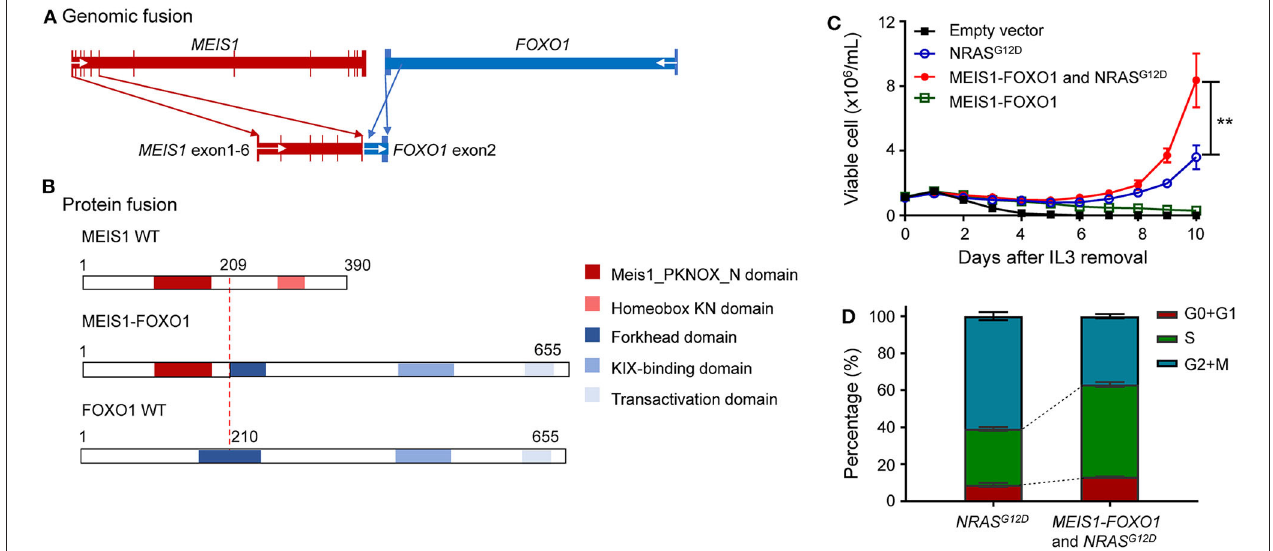
FIGURE 2 | Identification of oncogenic potential of MEIS1–FOXO1 fusion gene. (A) Schematic DNA representation of novel MEIS1–FOXO1 rearrangement (red, MEIS1 ; blue, FOXO1 ). (B) Fusion protein representation of novel MEIS1–FOXO1 rearrangement (red box, MEIS1 PKNOX N domain; pink box, homeobox KN domain; dark blue box, forkhead domain; light blue box, KIX-binding domain; gray blue box, transactivation domain). (C) MEIS1–FOXO1 potentiated leukemia transformation in Ba/F3 cell model. Effects of MEIS1 – FOXO1 fusion genes on Ba/F3 transformation. Following transduction of empty vector, MEIS1 – FOXO1 , NRAS G 12 D , or combination, Ba/F3 cells were cultured in IL-3 depleted medium with cytokine-independent cell growth as a measure of oncogenic transformation. Number of viable cells was evaluated daily. (D) MEIS1–FOXO1 fusion genes and proliferation of mouse hematopoietic progenitor cell Ba/F3. Ba/F3 cells were lentivirally transduced with empty vector (black), NRAS G 12 D (blue), MEIS1–FOXO1 (green), or combination of NRAS G 12 D and MEIS1–FOXO1 (red) and then cultured in the presence of IL-3 (10ng/ml). After 48h, cell cycle distribution was evaluated using standard PI staining protocol. Statistical significance, determined using the two-sided unpaired t -test, is indicated by ** P <